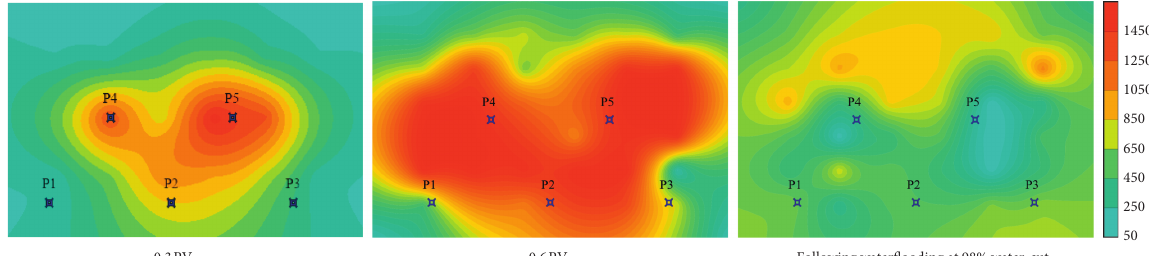
Figure 9: Variation of the polymer concentration field during chemical injection with no edge water.